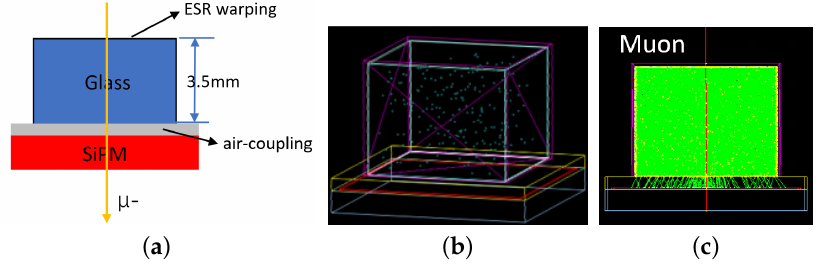
Figure 10. ( a ) The schematic of the geometry setup; ( b ) geometry display in the Geant4 simulation; ( c ) event display of a 1 GeV muon in the Geant4